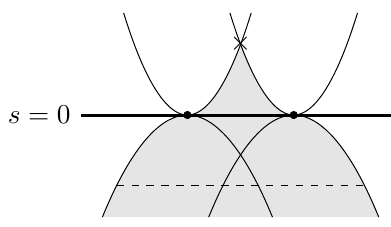
Figure 3 . Aspects of light-cones near a singularity hypersurface. Past and future light-cones of two points on the s = 0 singularity hypersurface H 0 , and domain of dependence (in gray) of a spacetime point (cross). Kasner exponents k a ± before and after the singularity are all less than 1 , except in the special case k 1 ± = k 2 ± = 0 , k 3 ± = 1 (and permutations thereof). Null geodesics then travel by a finite amount ∼ R ds/ | s | k a − in the three spatial directions before reaching the singularity, and likewise after the singularity, hence the domain of determinacy of a sufficiently large region (such as depicted by the dashed line) can include parts of the spacetime after the singularity. The fact that null rays can “traverse” the singularity enables us to set up null coordinates globally in the plane-symmetric gravitational collision problem treated in